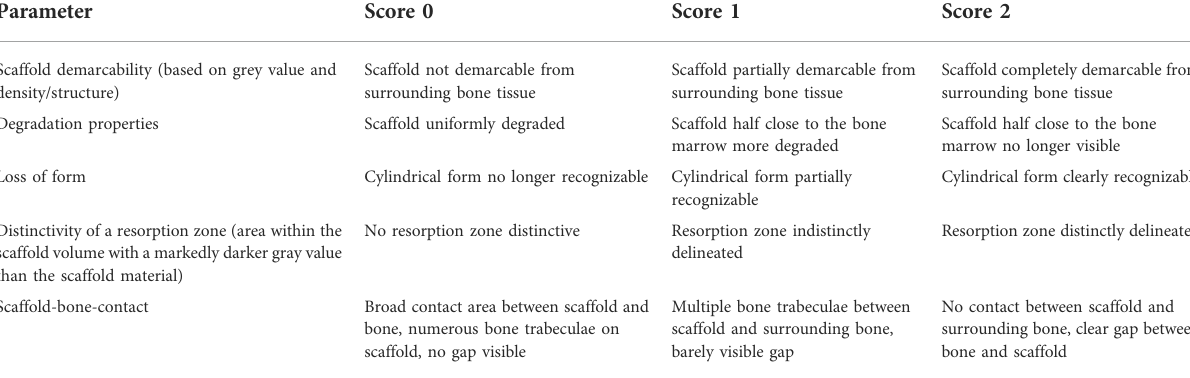
TABLE 2 Scoring system for the semi-quantitative evaluation of the in-vivo µCT scans.